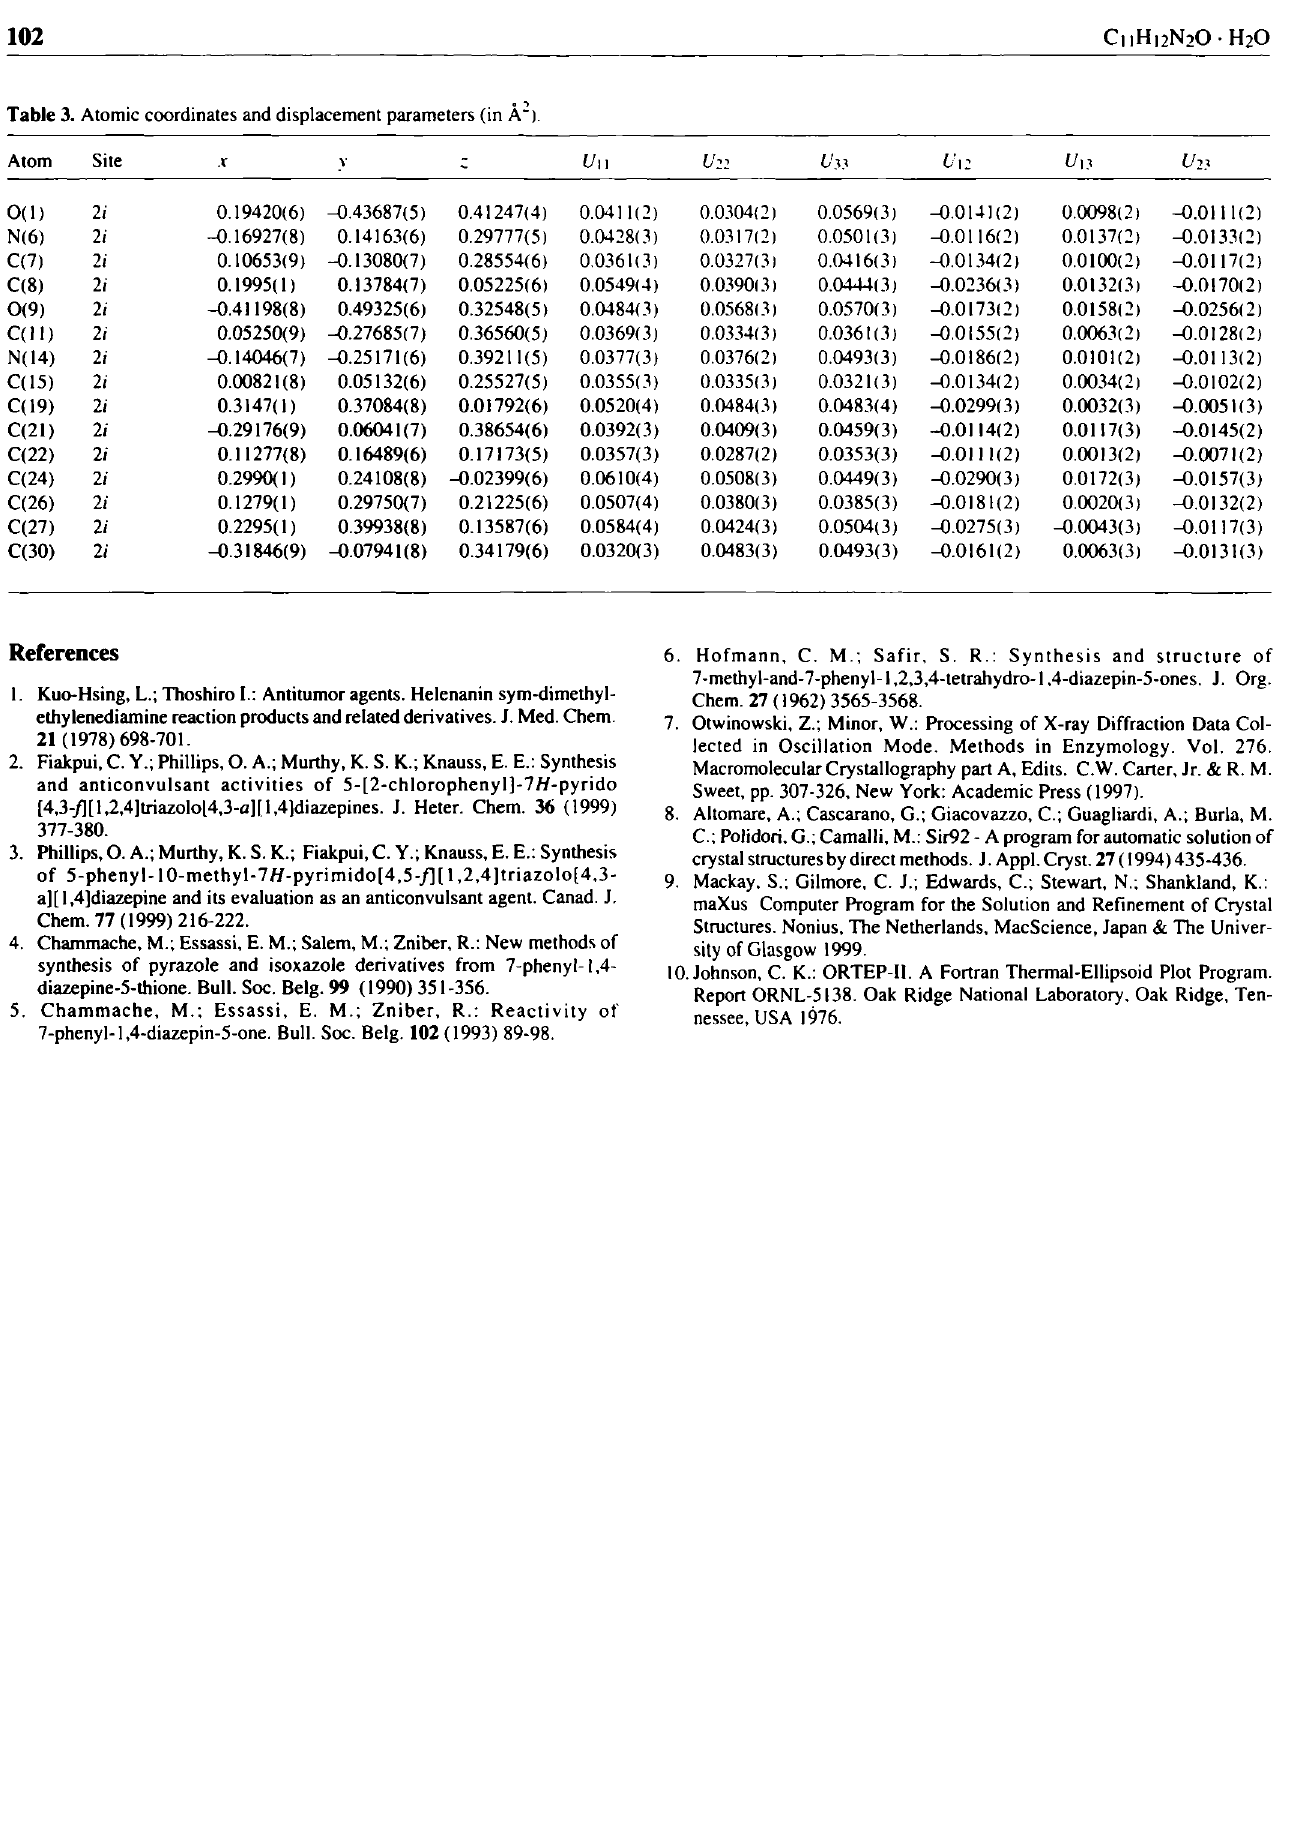
Table 3. Atomic coordinates and displacement parameters (in